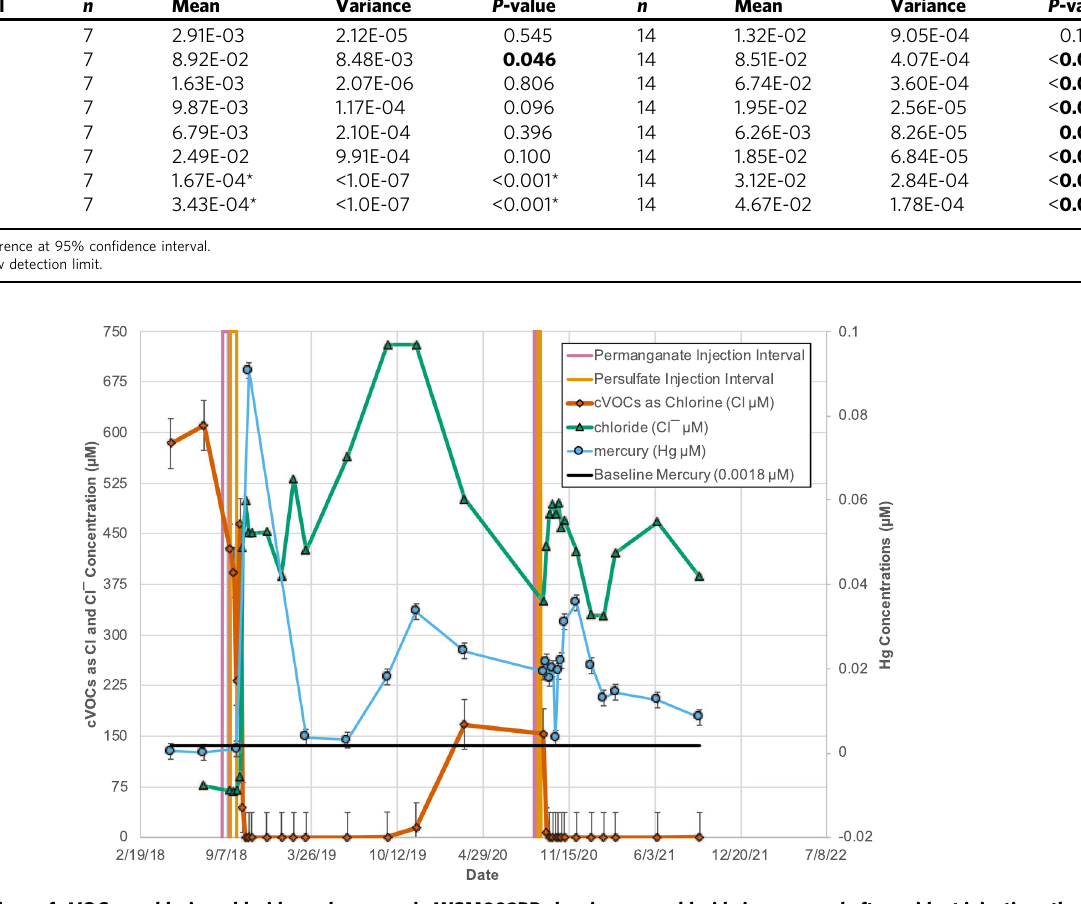
Fig. 5 Concentrations of cVOCs as chlorine, chloride, and mercury in WSM002BB showing more chloride is measured after oxidant injections than can be accounted for by destruction of aqueous phase cVOCs prior to injections. Reddish purple and orange lines indicate beginning and end of permanganate and persulfate solution injections, respectively. Vermillion line with vermillion diamonds mark concentrations of cVOCs as chlorine, which is depleted after oxidant injection. Bluish green line with large bluish green triangles mark chloride concentrations, which are higher than can be accounted for by cVOC destruction. Sky blue line with sky blue circles mark concentrations of mercury, which signi fi cantly increase after the second oxidant injections. Black line indicates average baseline mercury concentration. Duplicate analyses of PCE and TCE were performed on 11/25/19 (range 3 µ M combined as chlorine) and 3/16/20 (range 74 µ M combined as chlorine) so conservative error bars of ±37 µ M were placed on all cVOCs as chlorine data in the fi gure. Duplicate analyses of mercury were performed on 3/12/19 (range 0.0003 µ M), 11/25/19 (range 0.0037 µ M), and 3/16/20 (range 0.0005 µ M) so conservative error bars of ±0.0019 µ M were placed on all mercury data in the fi